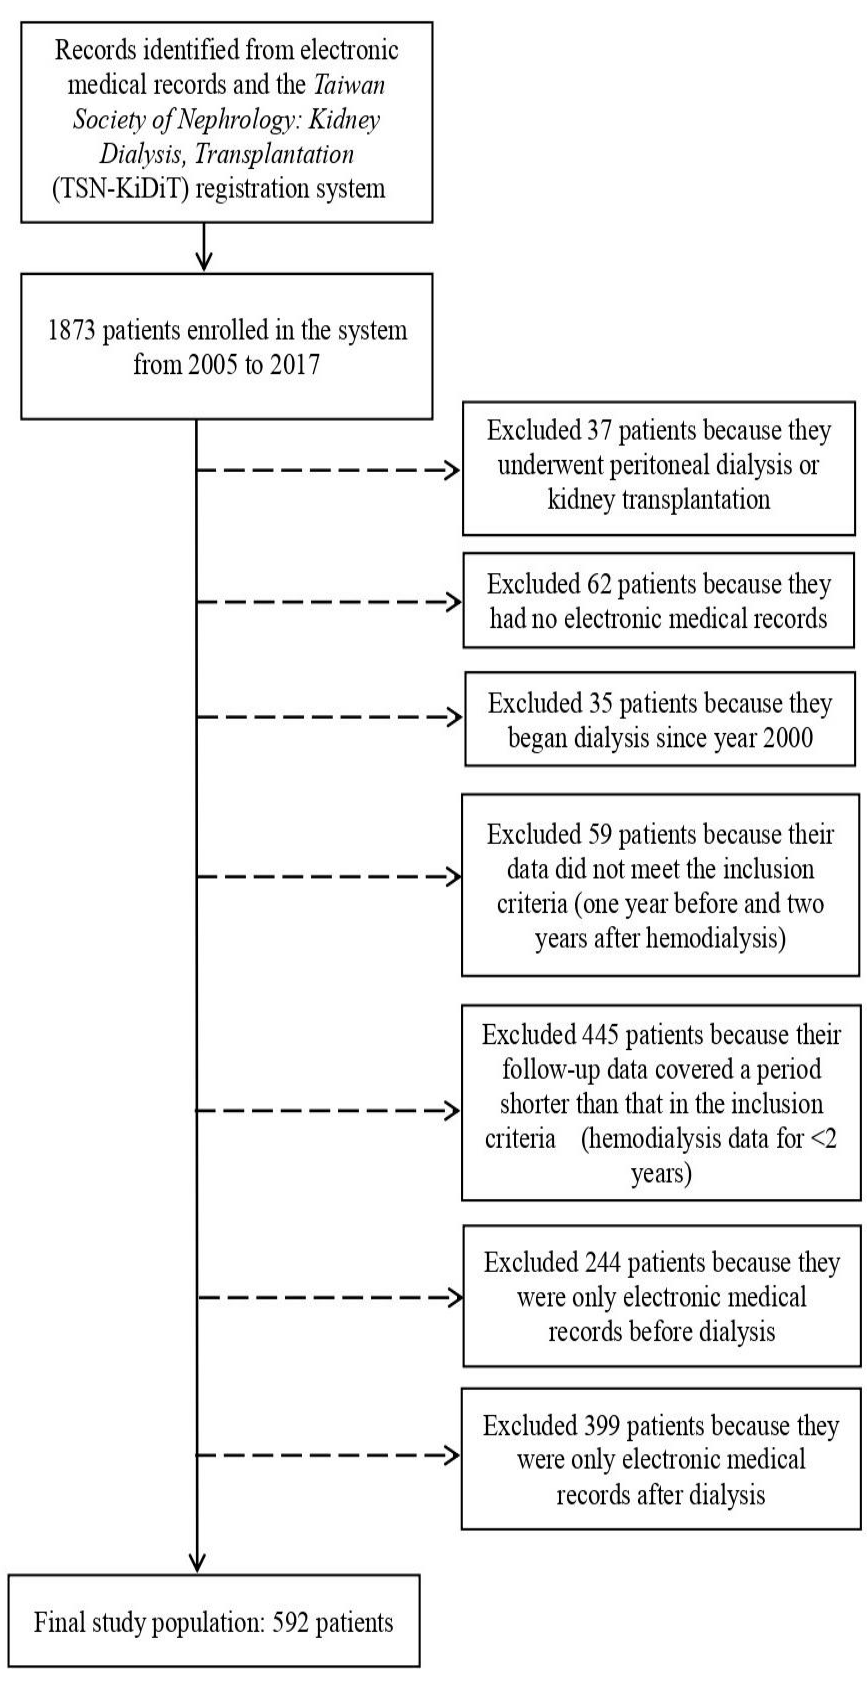
Figure 1. Patient flow chart of this study.